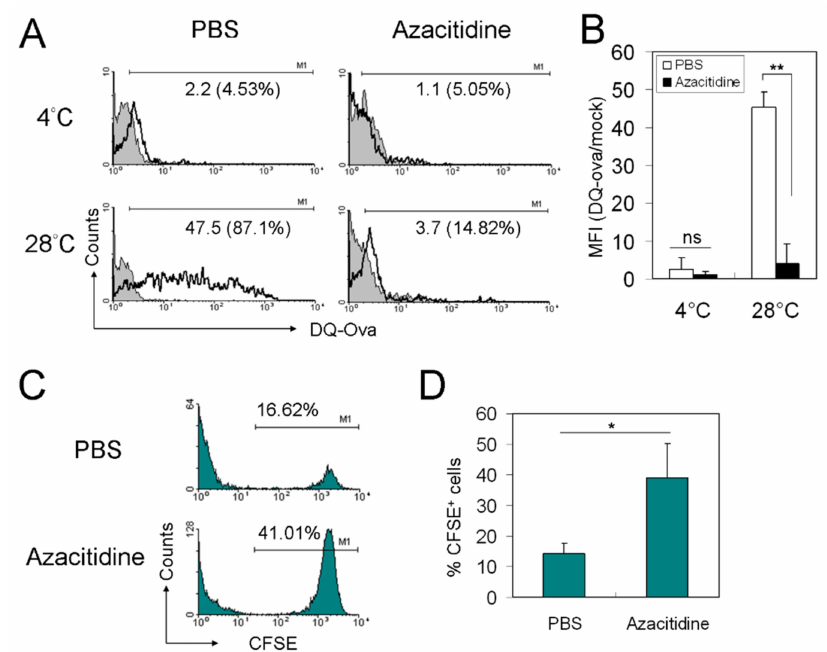
Figure 3. Impaired antigen processing and allogeneic rejection in azacitidine-treated zebrafish. ( A ) Plastic-adherent WKM cells from PBS- and azacitidine-treated zebrafish were incubated with DQ-Ova at 10 µ g / mL for 2 h at 4 ◦ C or 28 ◦ C before being analyzed by flow cytometry. The average of three independent experiments are shown as mean ± standard deviation (SD) in (B ). ( C ) CFSE-labeled ZLE cells (5 × 10 5 cells per animal) were injected retro-orbitally into PBS- and azacitidine-treated zebrafish. After 24 h, the animals were sacrificed and their peripheral blood cells were analyzed by flow cytometry. The average of five independent experiments are shown as mean ± SD in ( D) . * p < 0.05, ** p < 0.01, ns, not significant, by Student’s t